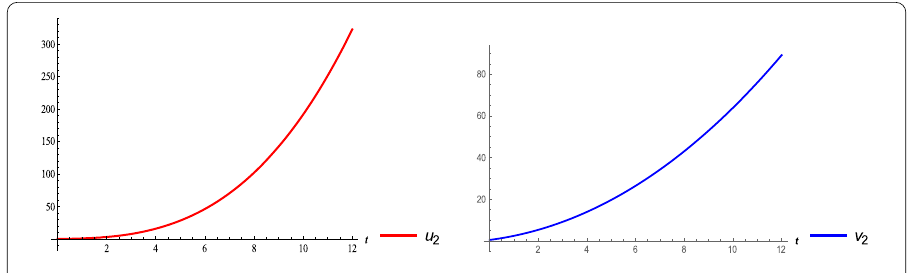
Figure 2 Two-dimensional surfaces of susceptible people and exposed people of system (10)